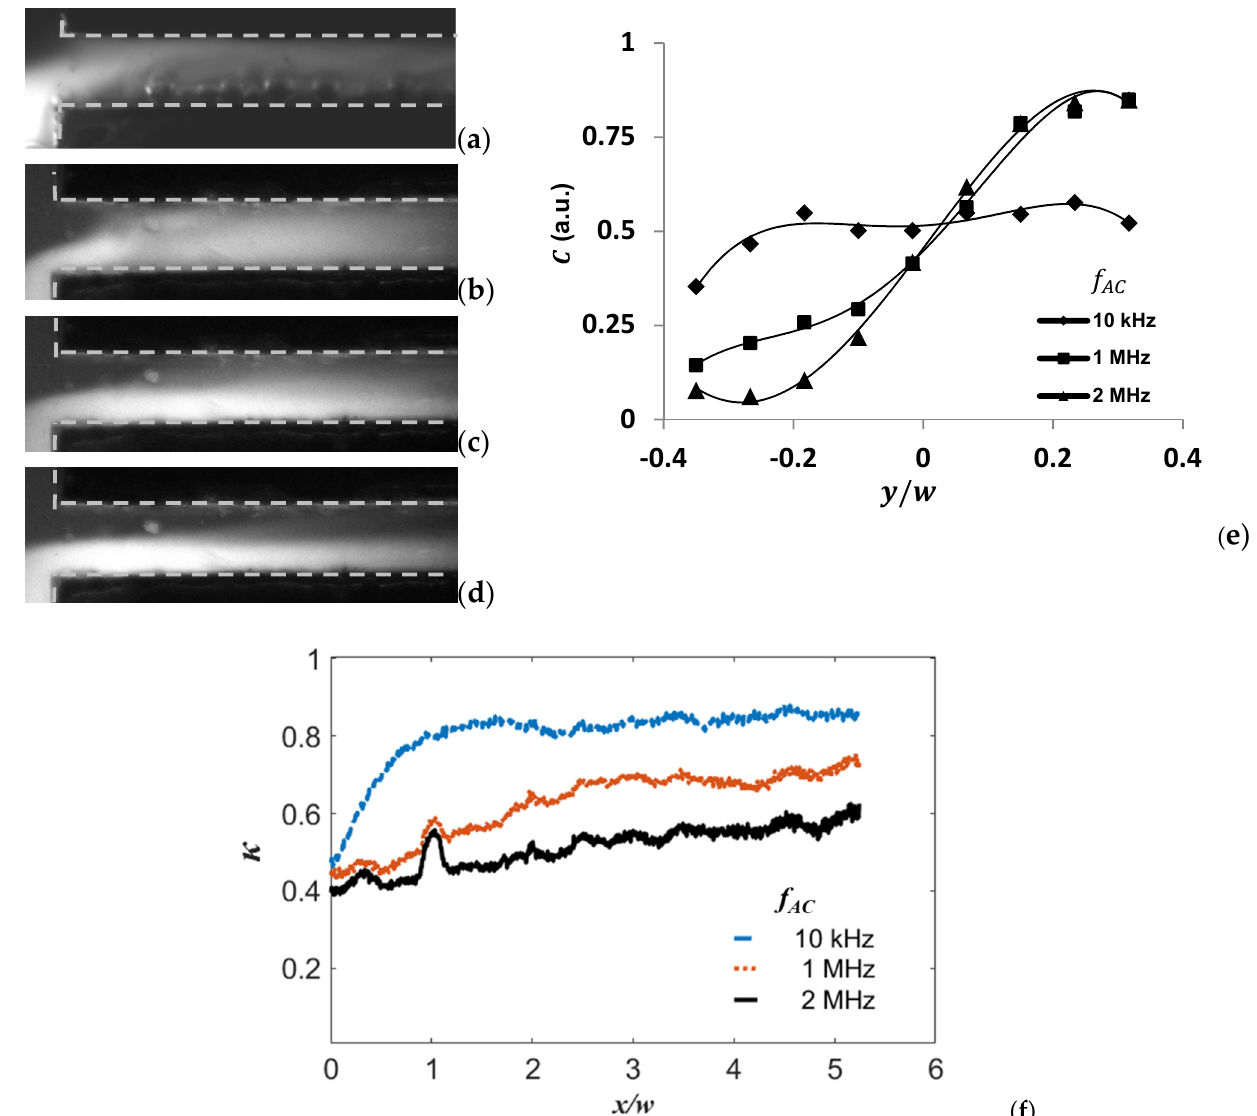
Figure 6. Visualization and comparison of mixing results in microchannels with different frequencies of AC and DC signals. Here, γ = 10 and E A = 1000 V/cm. ( a ) DC, ( b ) f AC = 10 KHz, ( c ) f AC = 1 MHz, ( d ) f AC = 2 MHz, and ( e ) comparison of concentration profile in transverse direction at x = 2.3 w from the channel entrance with AC signal. ( f ) Mixing index varying along streamwise direction at different AC frequencies.